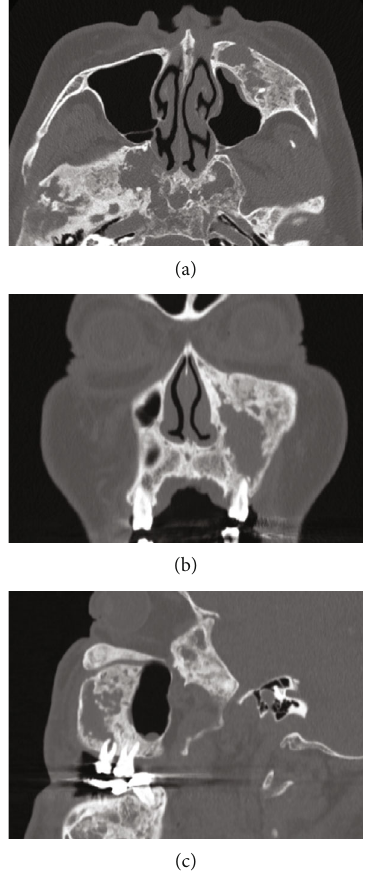
Figure 2: Computed tomography (CT) image obtained at the initial visit. CT shows bone hyperplasia and “ ground-glass ” appearance at the left maxilla, mandible, and sphenoidal bone, along with an osteolytic lesion extending from the root apex of the left maxillary fi rst molar to the inferior aspect of the left infraorbital foramen and canal in the “ ground-glass ” lesion. Axial (a), coronal (b), and sagittal (c) CT